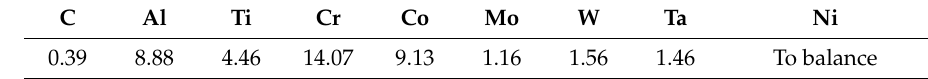
Table 1. Chemical composition of the IN 792 DS superalloy (at %).